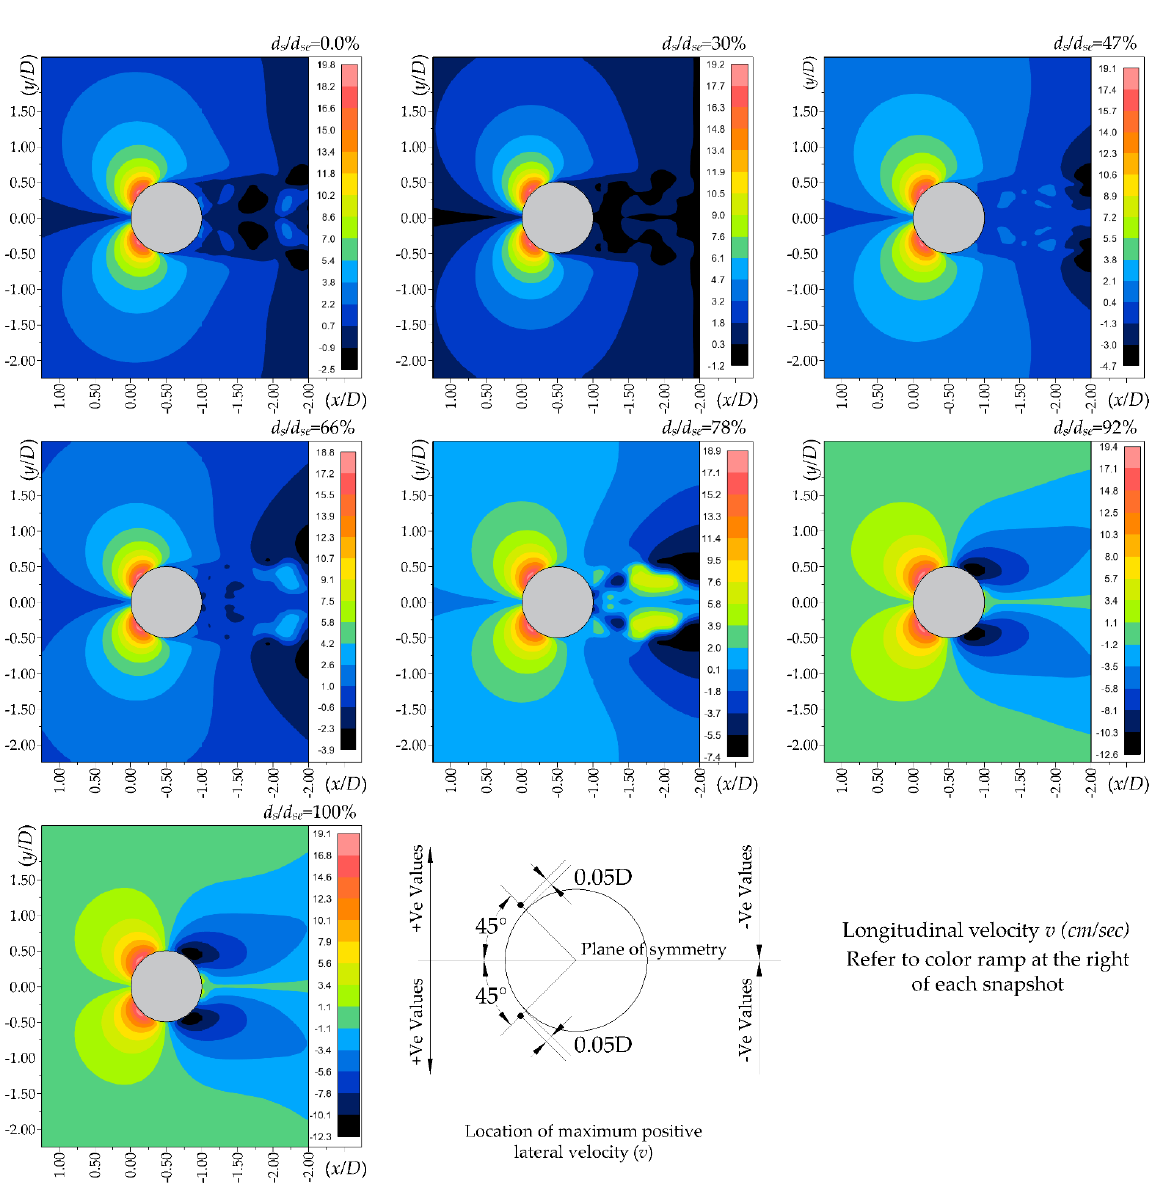
Figure 10. Simulated lateral velocity distribution at 𝑧/𝐻 𝑜 = 0.5 .